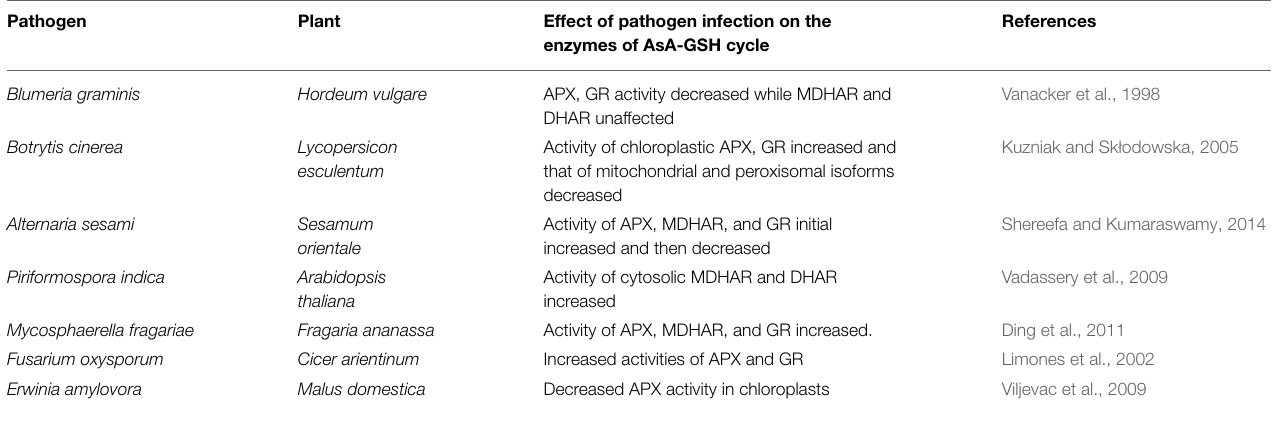
TABLE 3 | Representative examples of modulation of plant antioxidant activities by different pathogens.